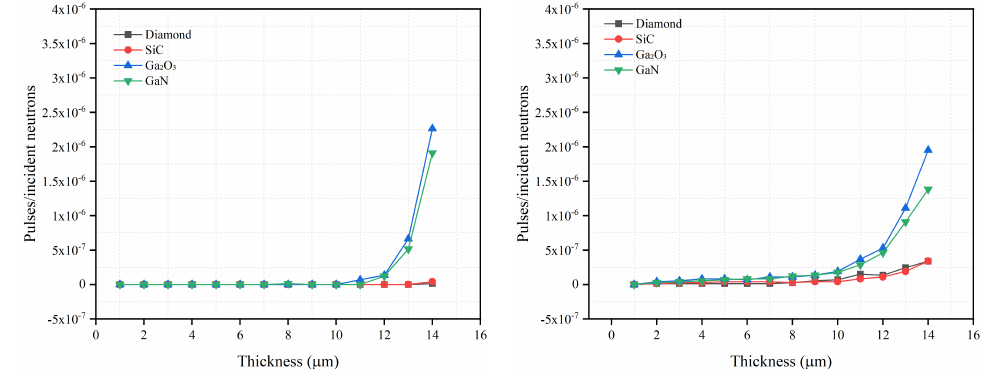
Figure 5. Gamma–ray detection efficiency to 511 keV photons ( left ), to 1460 keV photons ( right ) versus semiconductor thickness for 300 keV LLD with optimal B 4 C converter layer thickness for diamond, SiC, Ga 2 O 3 and GaN semiconductor materials. The optimal B 4 C converter layer thickness is 2.6 µ m for 300 keV LLD, as shown in Table